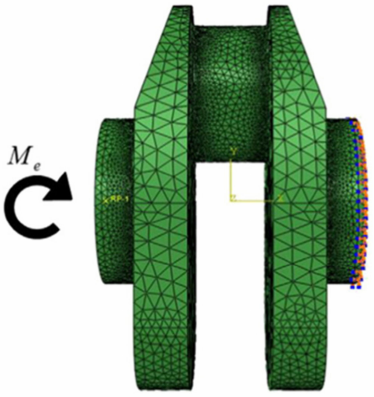
Figure 14. The finite element model of the